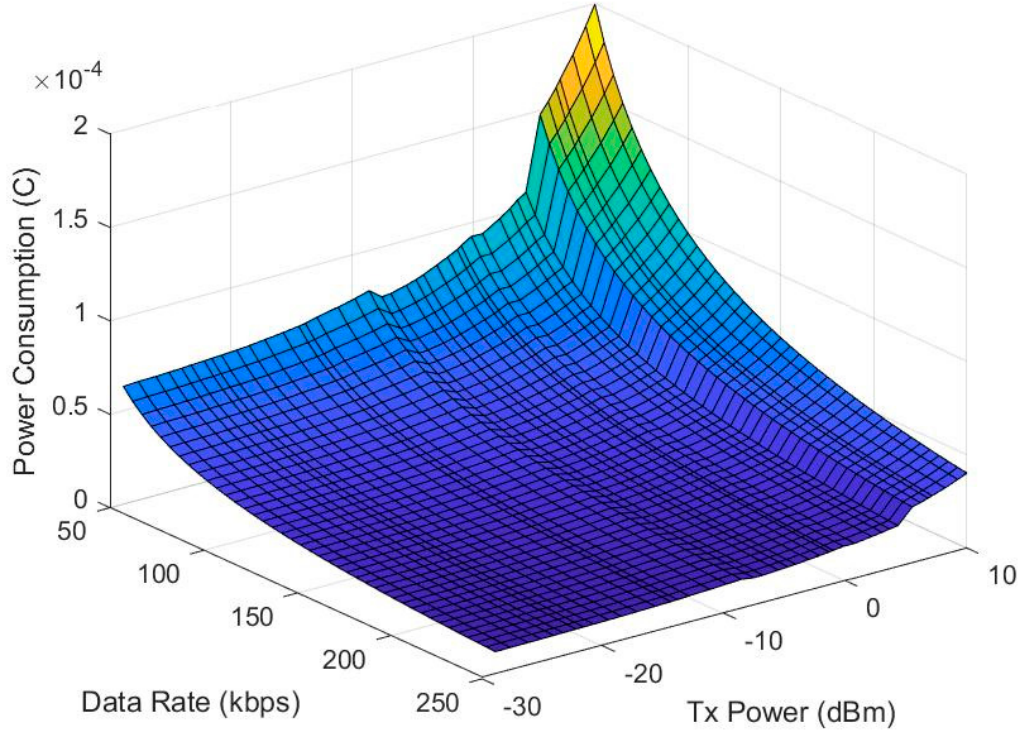
Figure 8. Relation of data rate, transmission power, and power consumption.